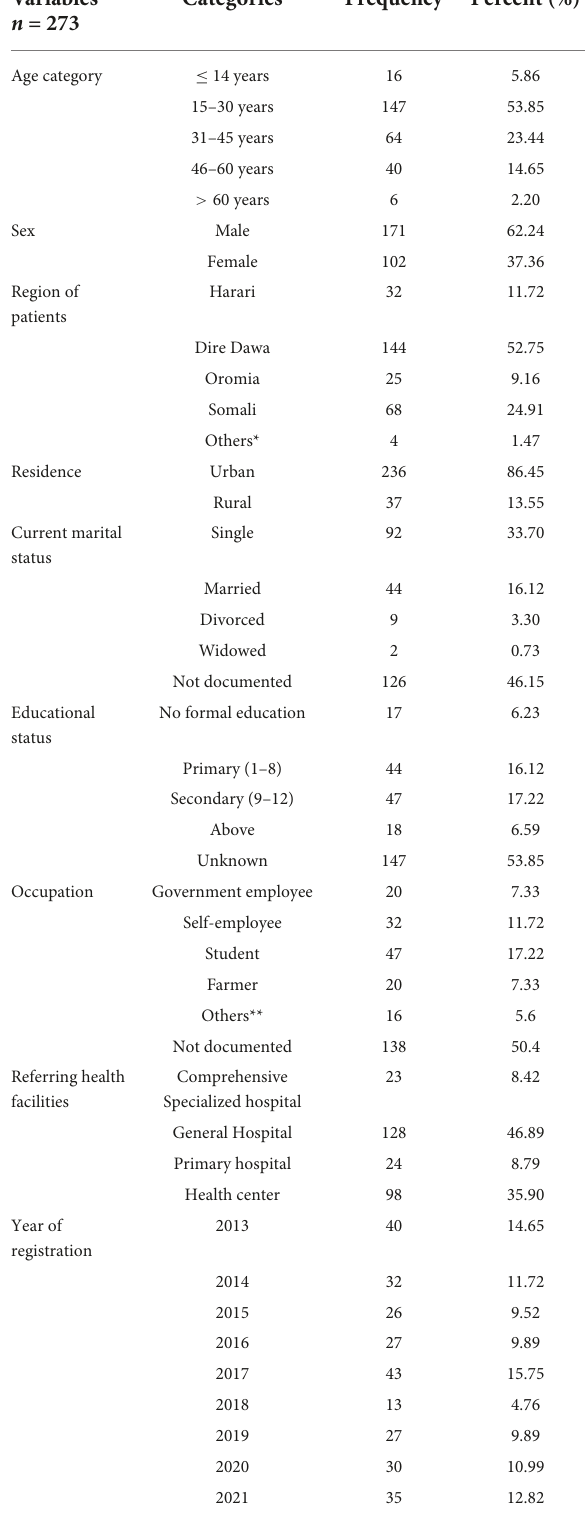
TABLE 1 Socio-demographic and behavioral characteristics of DR-TB patients in Harari regional state and Dire Dawa city administration, eastern Ethiopia, from 2013 to 2021 ( N =